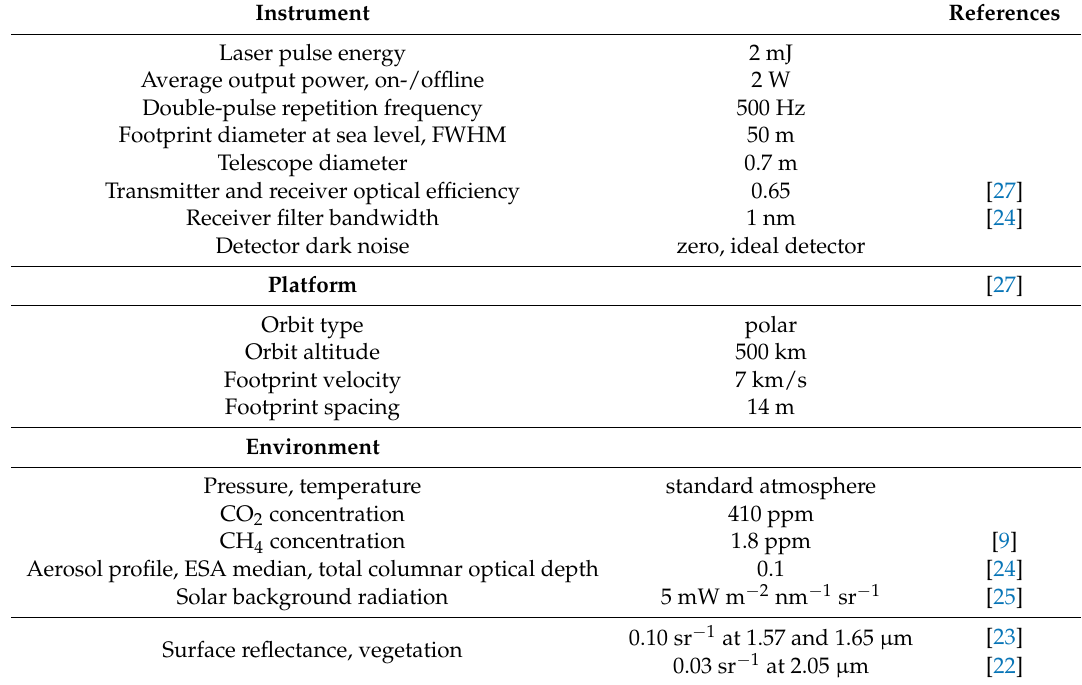
Table 2. Instrument, platform and environmental parameters used for the space Lidar